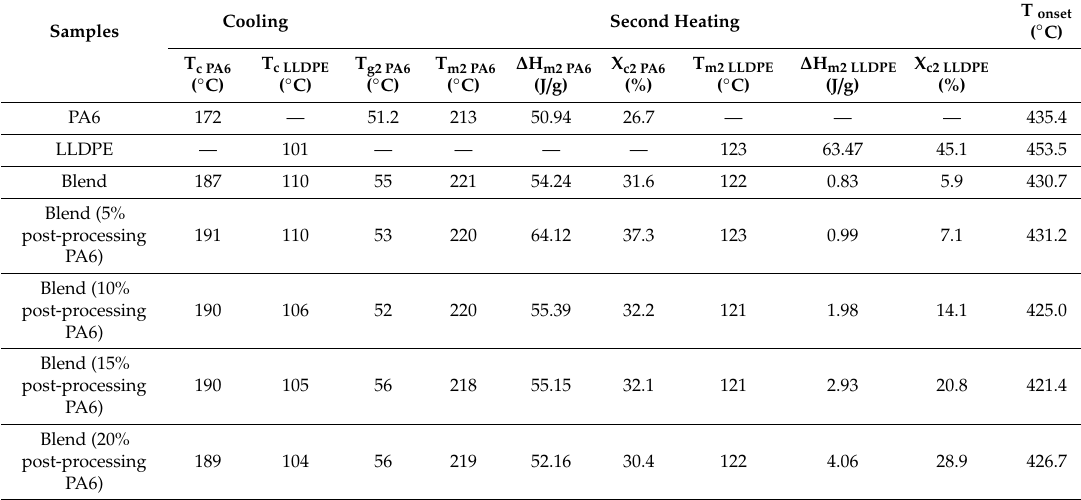
Table 4. Values of T c obtained during cooling, T g , T m , ∆ H m, and X c obtained during second heating and T onset obtained by TGA.